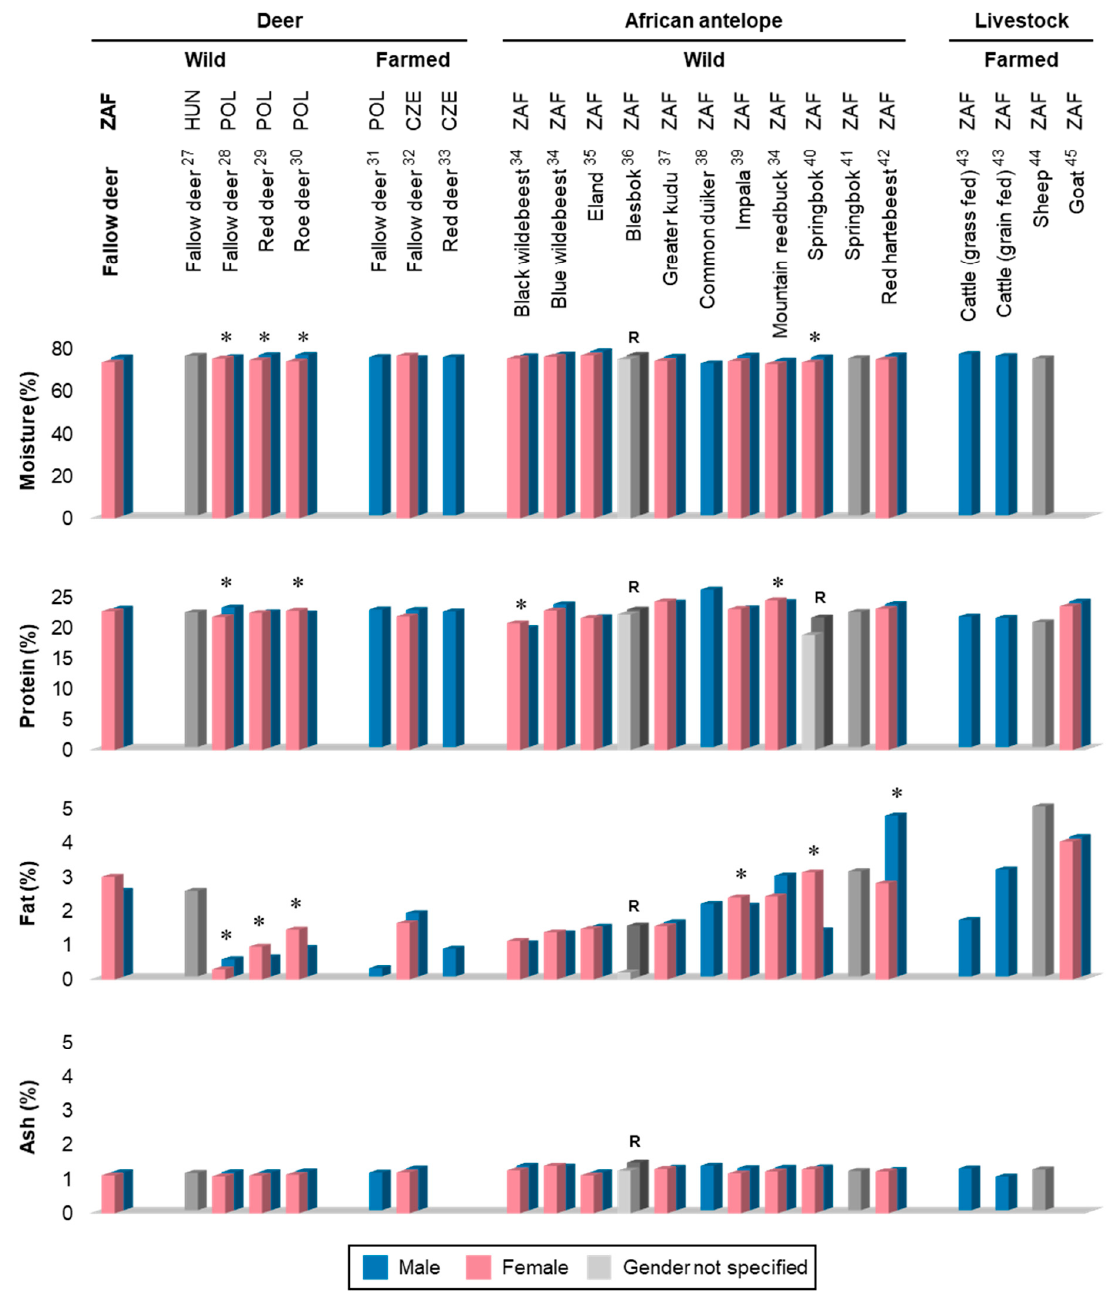
Figure 1. Proximate composition of longissimus thoracis et lumborum muscles from selected game and ruminant livestock species, including sex comparisons where applicable. Values obtained in the present study appear in the first column (label marked in bold). The superscript numbers indicated after each species refer to references in the reference list [27–45]. * Indicates studies in which a significant sex e ff ect was found; “R” indicates studies in which a range of values were reported.